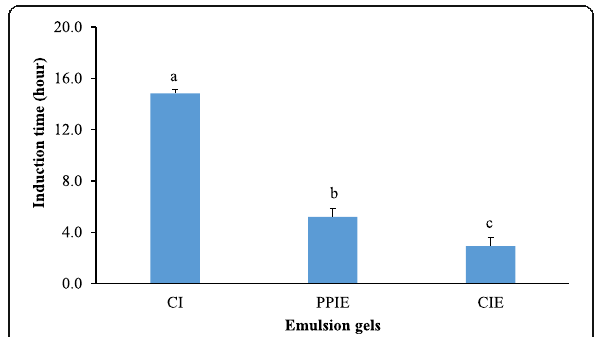
Fig. 8 Induction times of emulsion gels containing CI, PPIE, or CIE tested by Rancimat. PPIE: primary purified inulin extract from JA; CIE: crude inulin extract from JA; CI: commercial inulin from chicory root. Results represent mean ( n = 2), and standard deviation value is used as error bar. Values with different superscript letters are significantly different ( p <